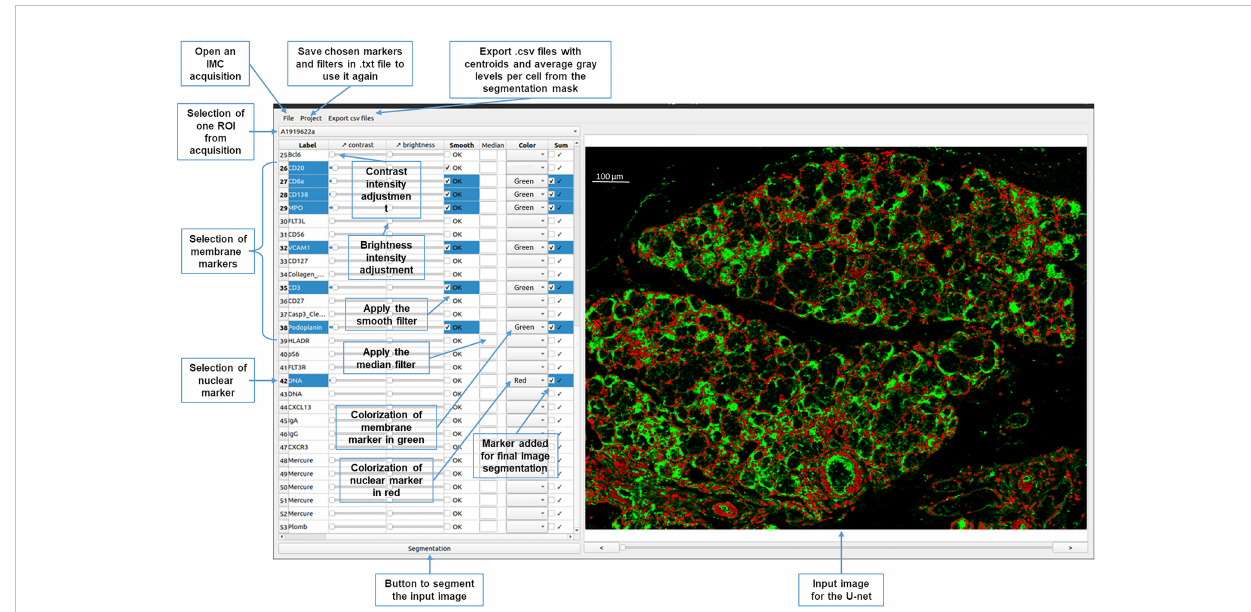
FIGURE 3 Graphical interface of the YOUPI software. An overview of the graphical interface and the ease-of-use functions of the YOUPI software.